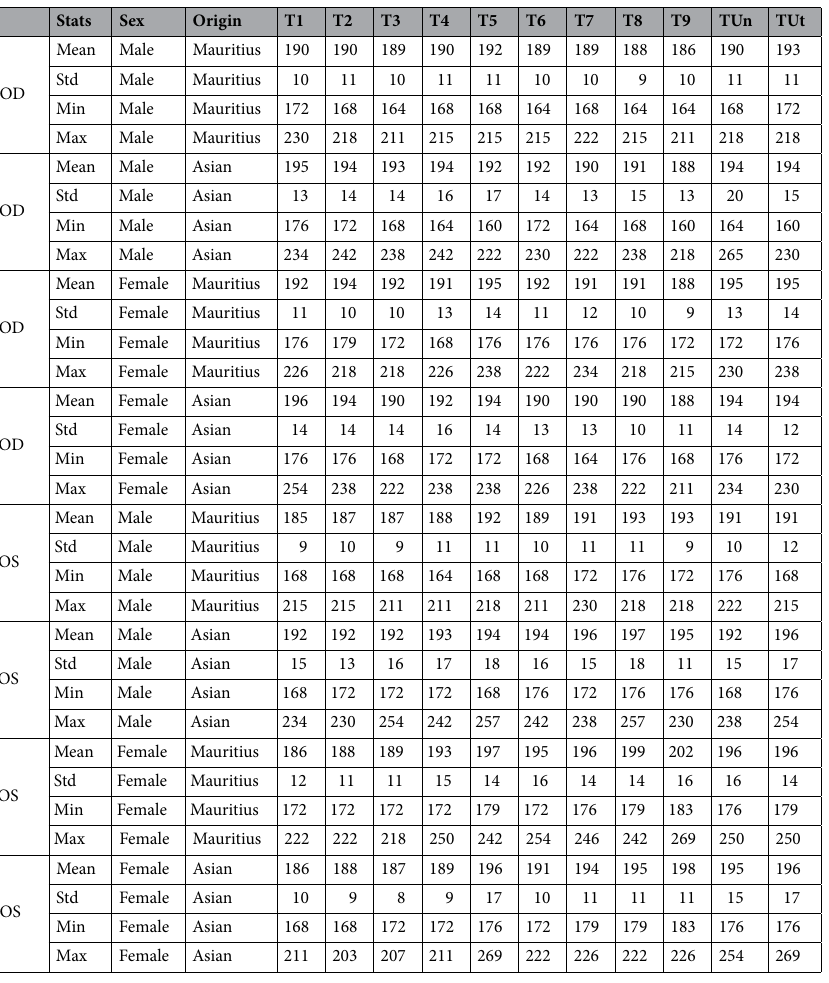
Table 2. Summary statistics of the choroid thickness values. OD oculus dexter, OS oculus sinister, Stats statistical analysis, T thickness, U umbo, n nasal, t temporal, std standard deviation, min minimum, max maximum, values in